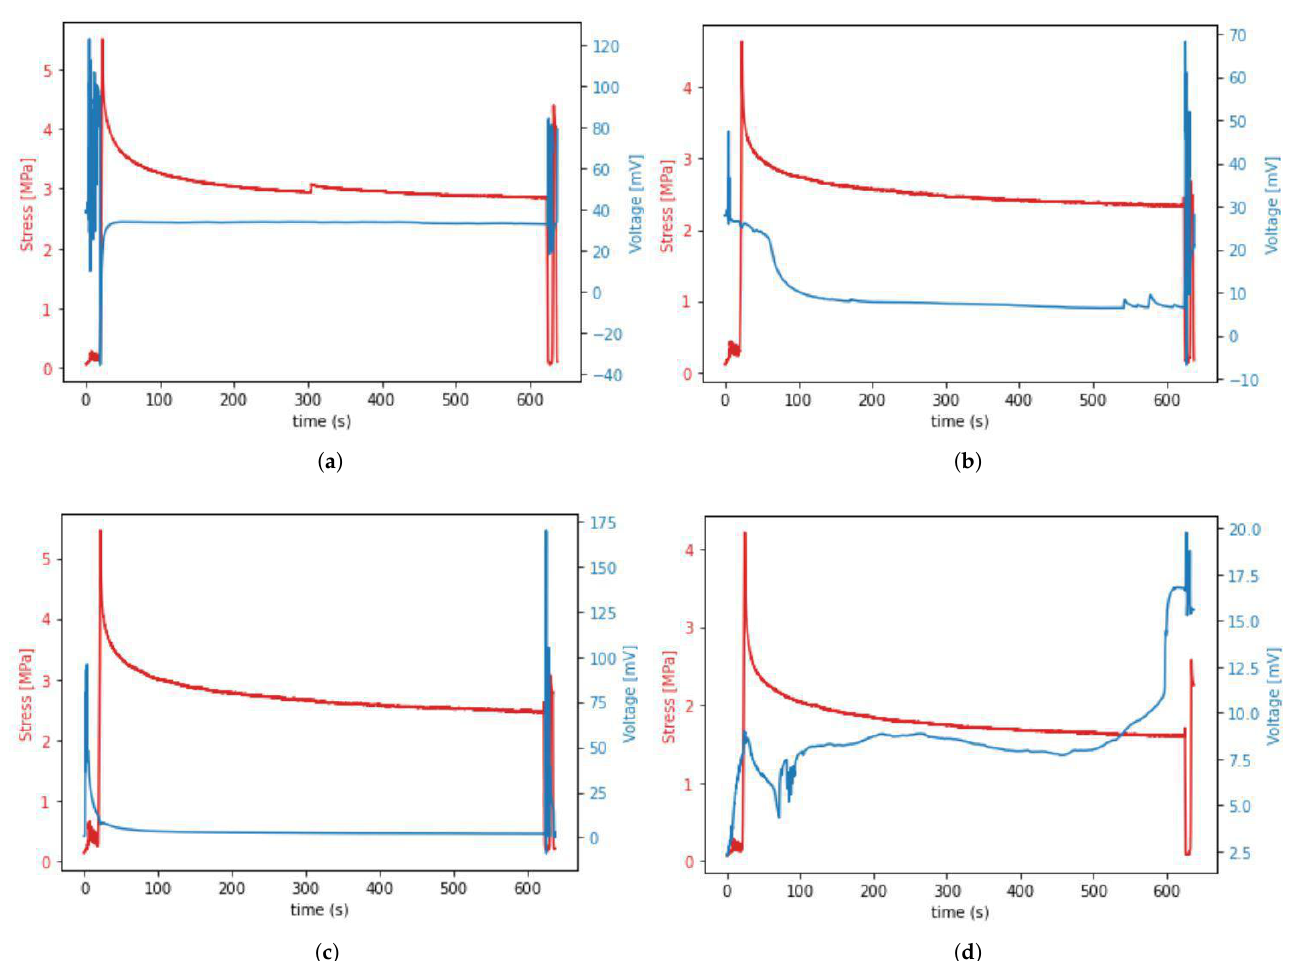
Figure 9. ( a – d ) The four most common voltage waveforms occurring during the piezoelectric effect in porcine